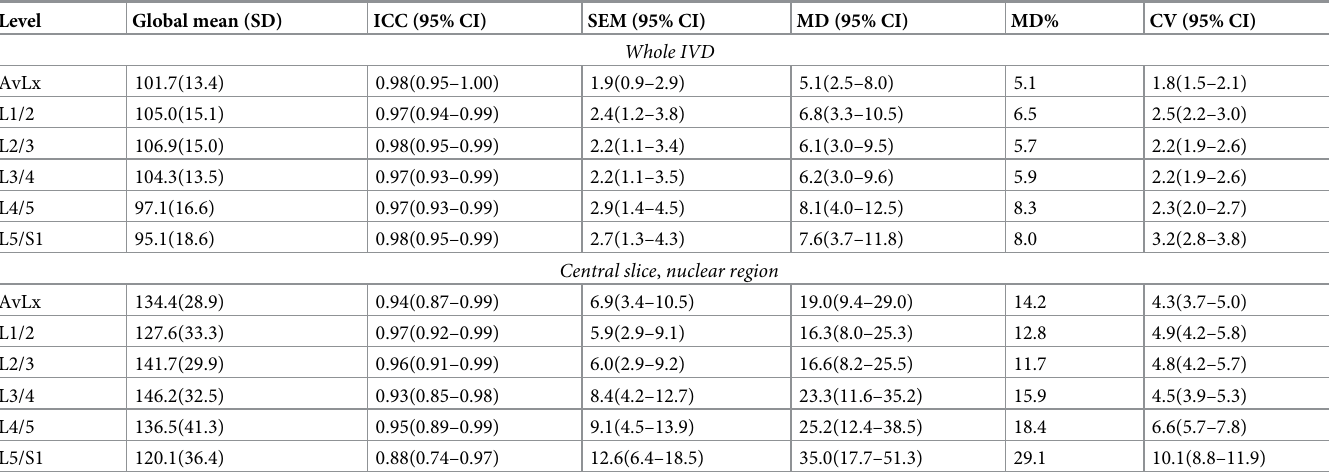
Table 1. Whole (top) and nuclear (bottom) intervertebral disc T 2 reliability.